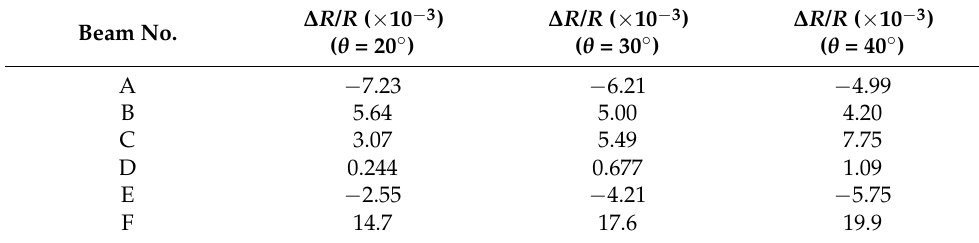
Table 7. Calculated results for ψ = 5